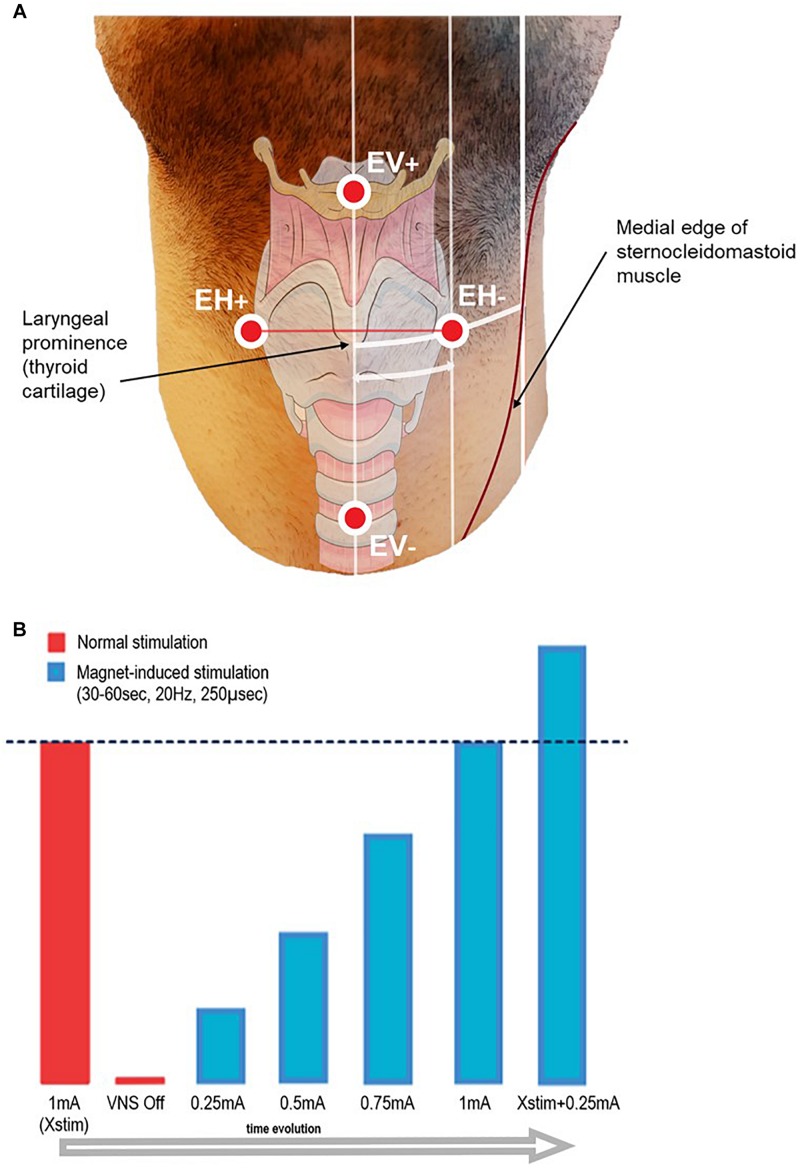
(A) Schematic representation of the recording surface electrode placement. EH+/EH– electrodes were aligned horizontally, and placed symmetrically on each side of the laryngeal prominence, at half the distance between the midline and the medial edge of the sternocleidomastoid muscle (approximately 4 cm). EV+/EV– electrodes were aligned vertically, placed on the midline 6 cm above and below the laryngeal prominence. Additionally, two electrodes for artifact recording (Art1–Art2) were placed on the left mastoid and below the left clavicle side of the neck (not shown in figure), and one grounding electrode was placed on the forehead (not shown in figure). The distances take into account an approximation due to the curvature of the neck and due to the perspective of the image. (B) Scheme of the stimulation protocol.